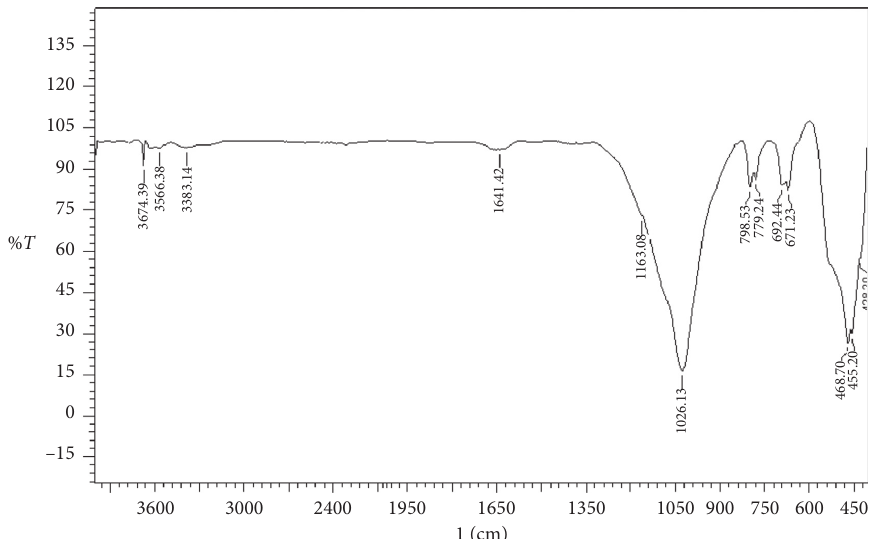
Figure 14: Infrared spectrum of the ZnO/sepiolite composite prepared by the powder sintering method.